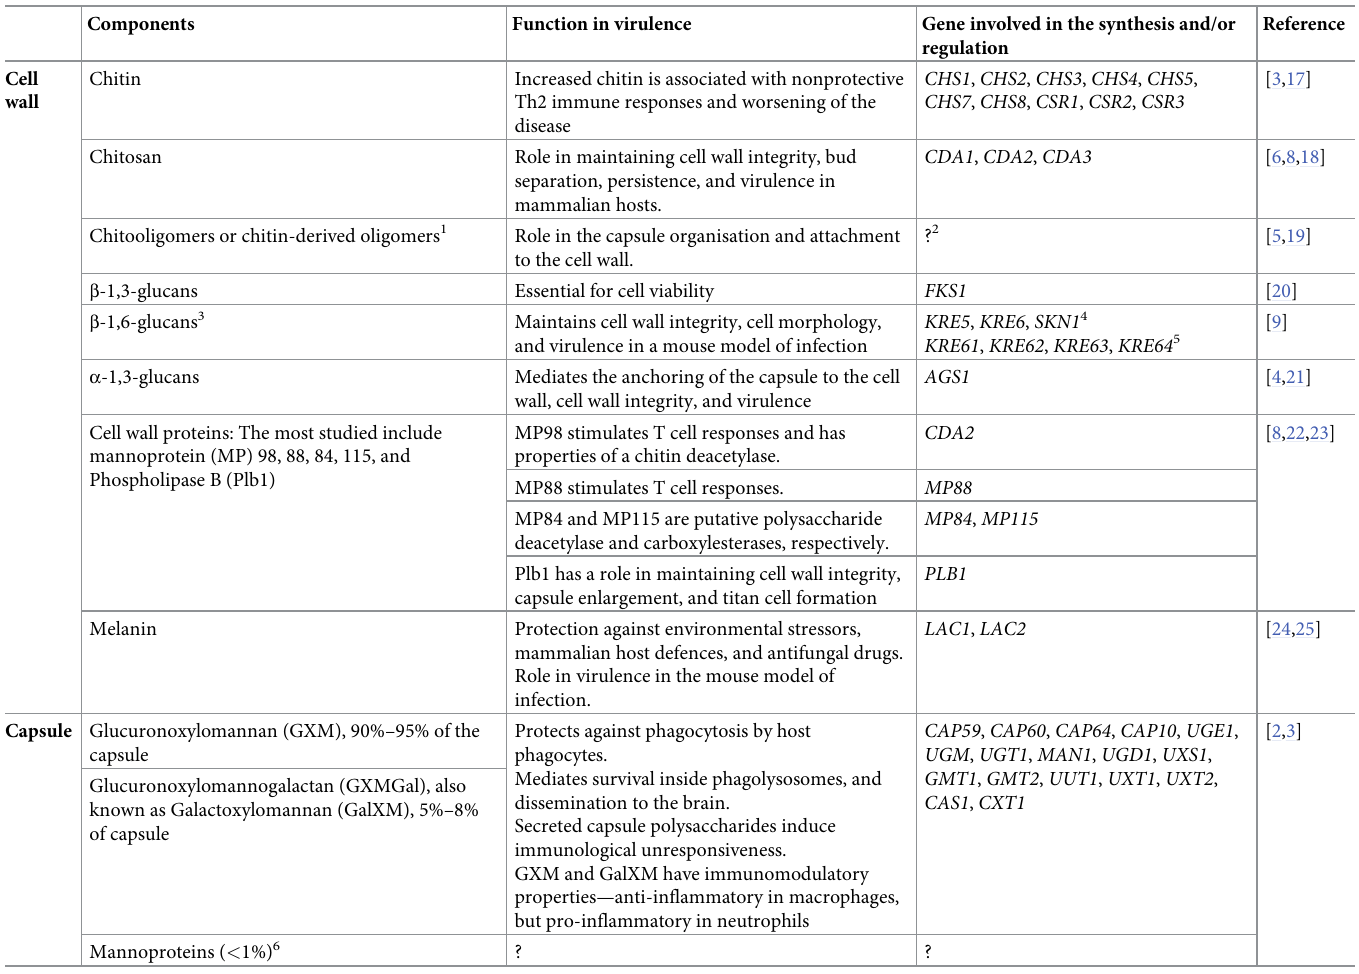
Table 1. Chemical signature and function of the Cryptococcus cell wall and